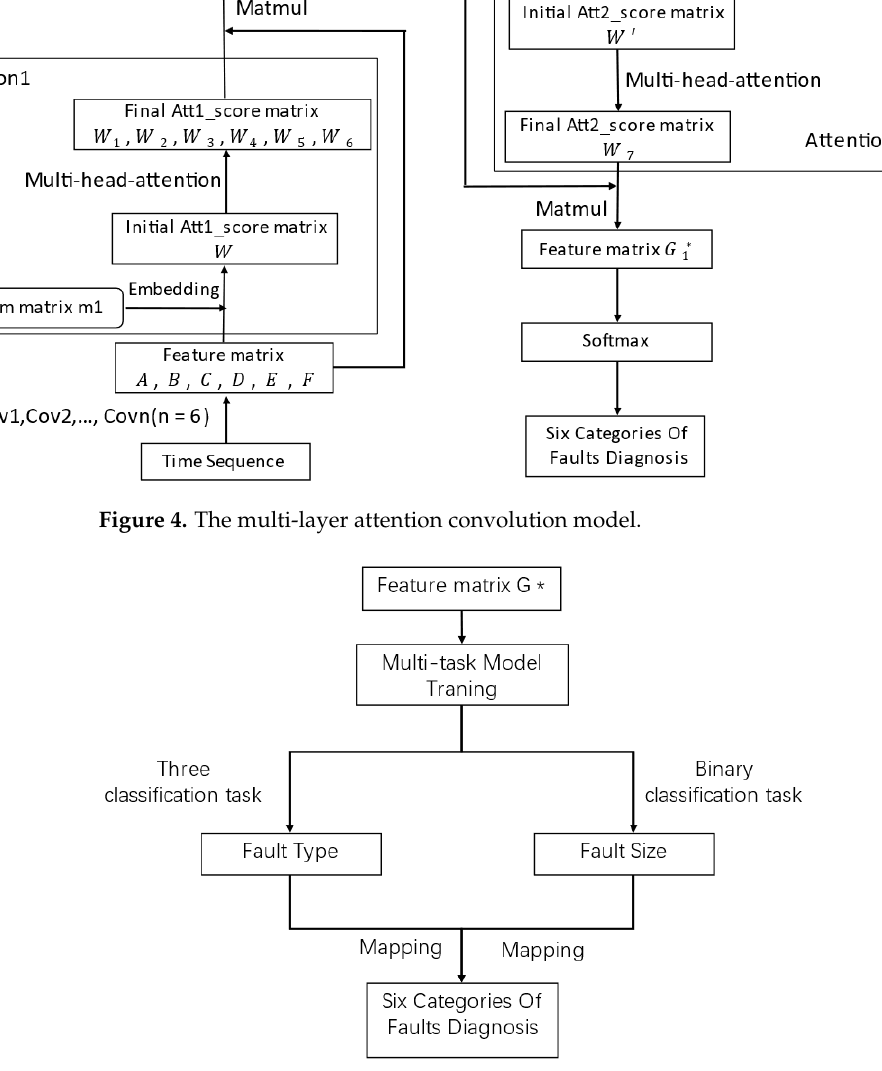
Figure 5. Multi-task